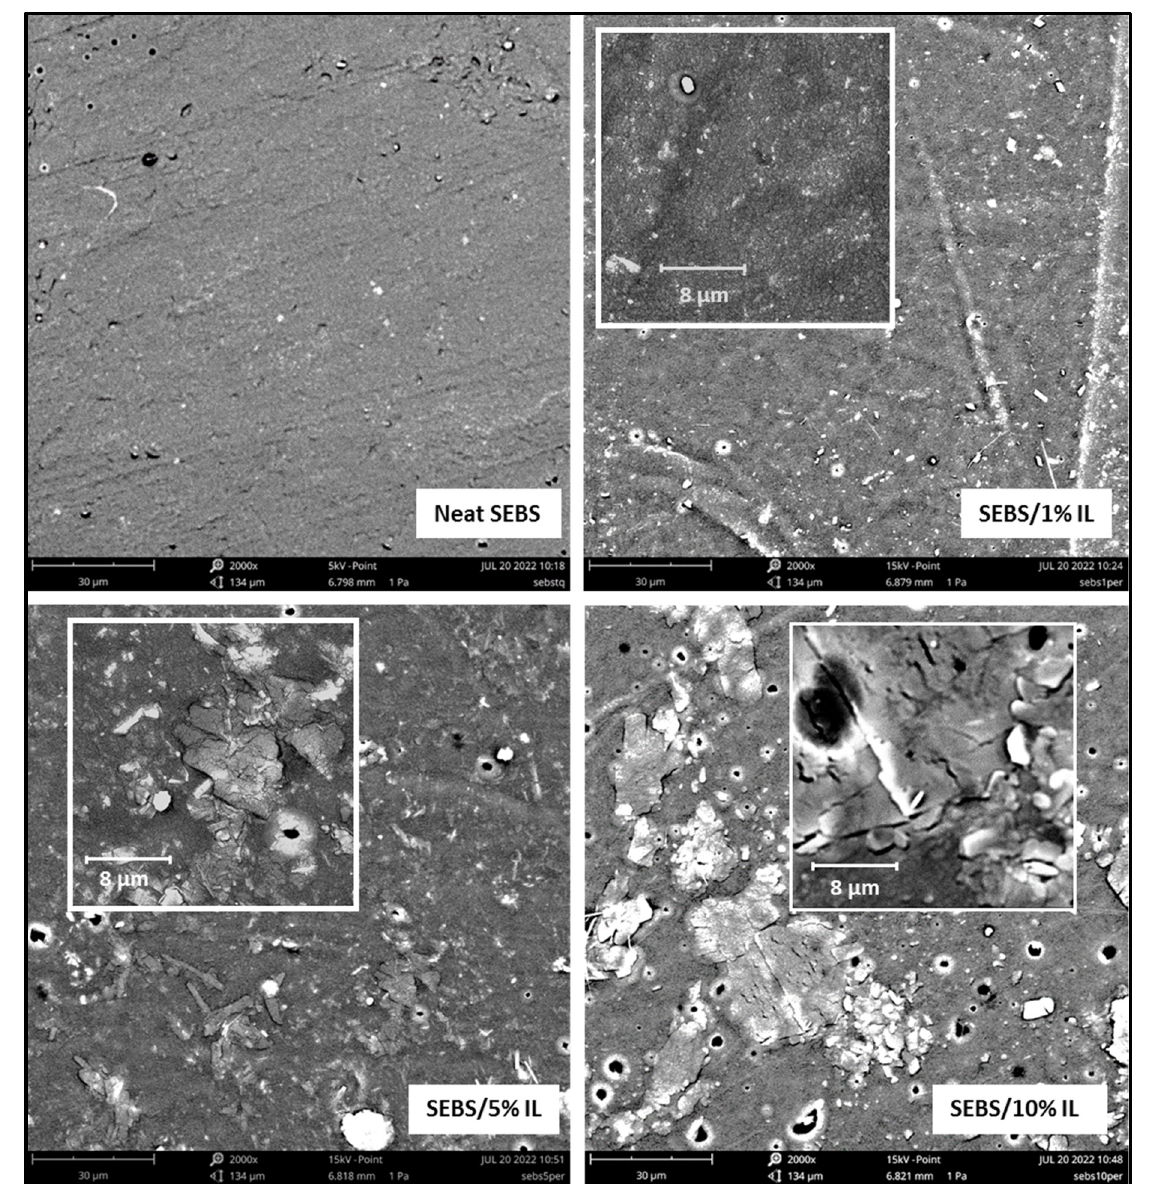
Figure 14. SEM images of neat SEBS and SEBS/ HdmimDMSIP blends . Inset magnification